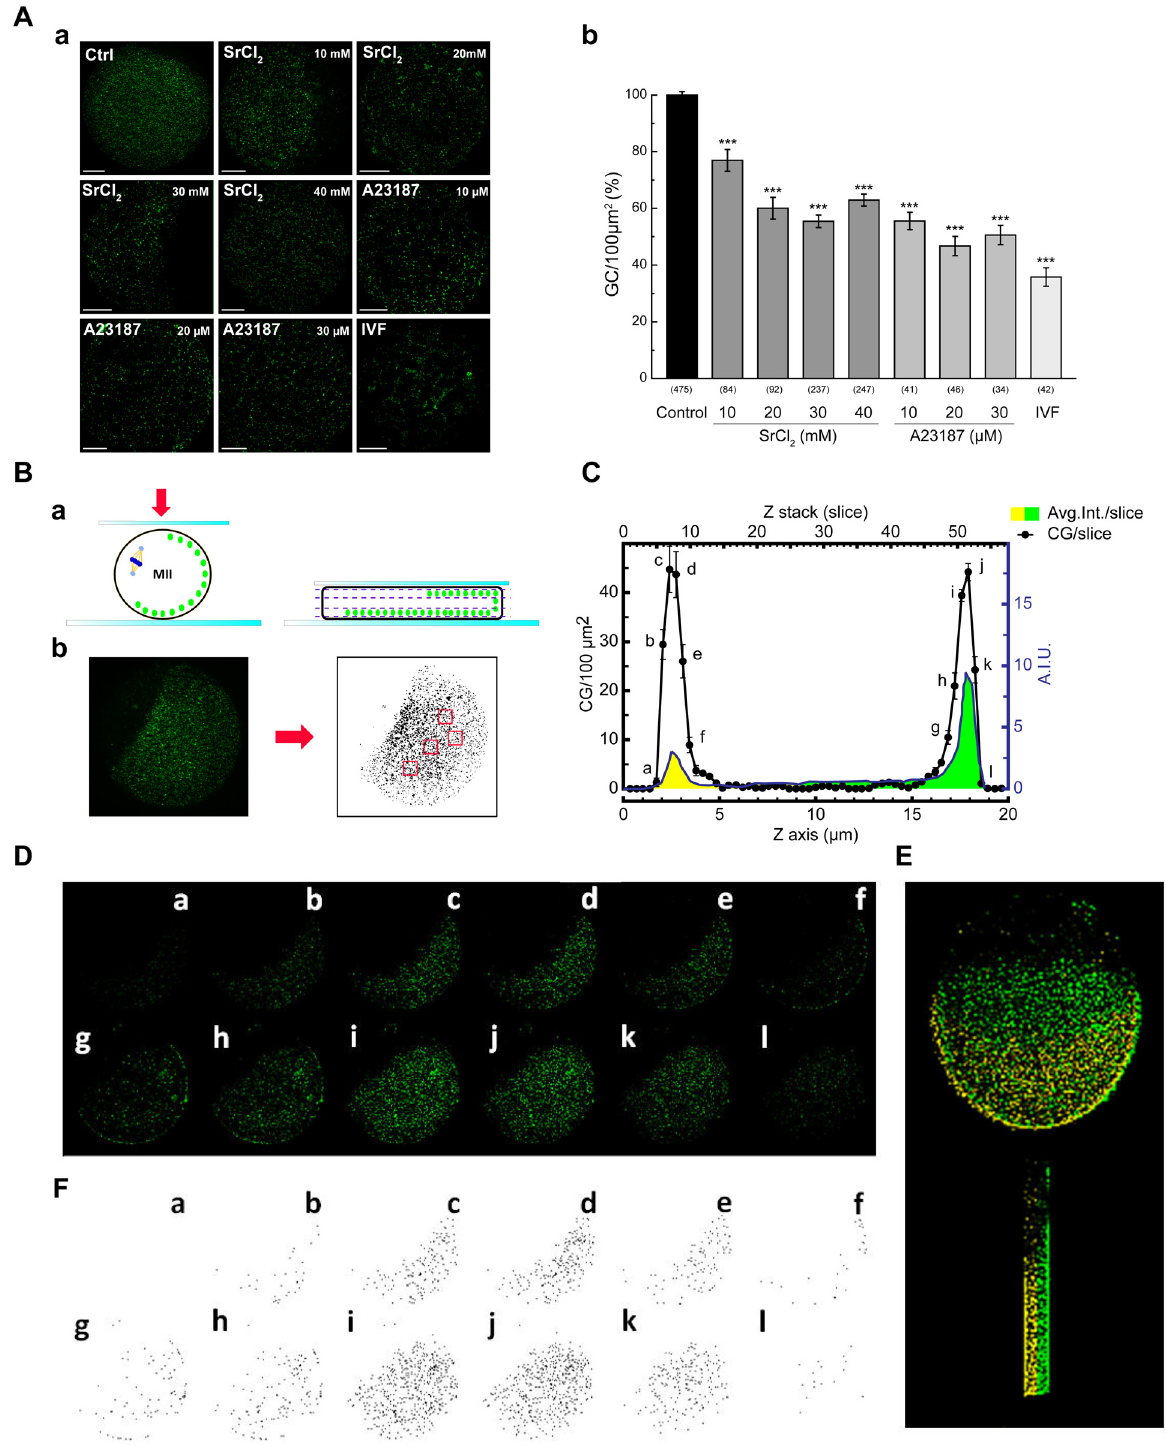
Fig 4. Functional assay of cortical granule exocytosis. A . Cortical granule exocytosis (CGE) was triggered bySrCl 2 (10-40mM), A23187 (10 – 30 μ M) or in vitro fertilization (IVF, cells fixed after 6 h co-incubation), and cortical granules (CG) were quantified. a , representative confocal images of oocytes subjected to different treatments, fixed and stained with FITC-LCA to label cortical granules. Scale bar: 20 μ m. b , histogram shows CG density (% CG density/100 μ m 2 ) relative to untreated group (control) set as 100%. Data are shown as mean ± SEM from at least 3 independent experiments; numbers in parentheses below bars represents total number of activated MII oocytes (SrCl 2 , A23187) or embryos (IVF). *** , p (cid:1) 0.001 (Tukey ’ s test). B . a , schematic diagram depicting